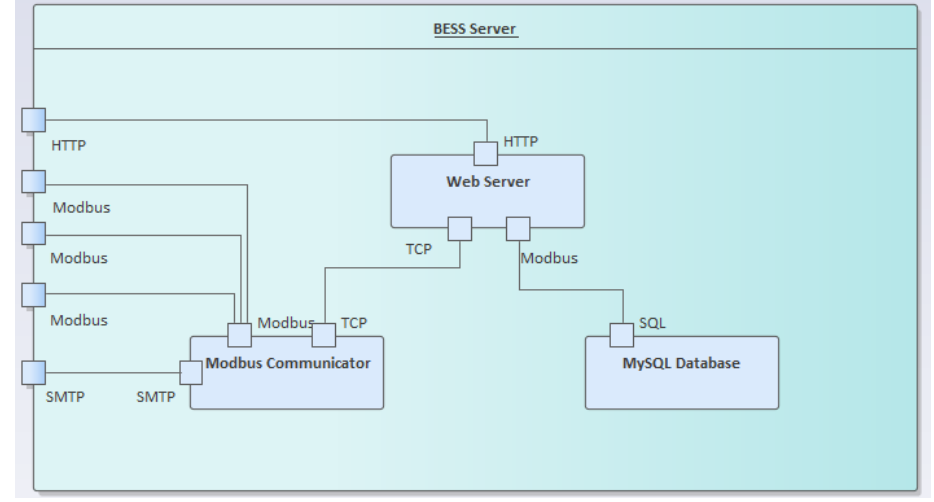
Figure 4. Diagram of the battery energy storage (BES) communication architecture.